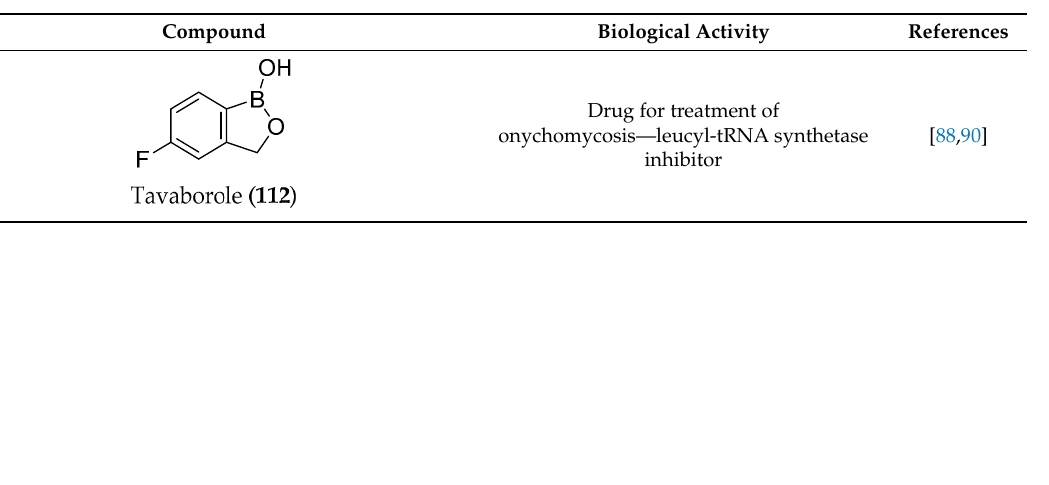
Table 8. Examples of known biological activities of benzoxaborole compounds.